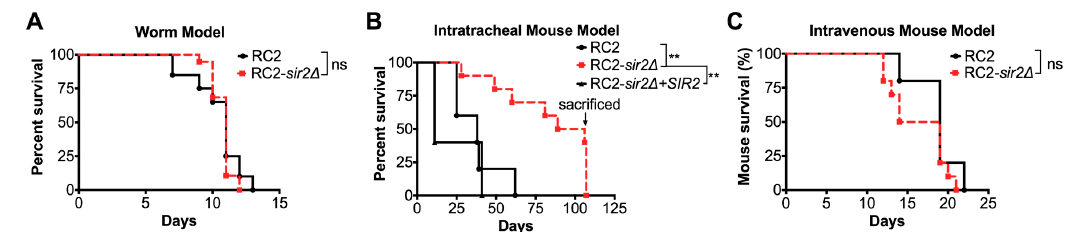
Figure 3. SIR2 loss affected virulence in some infection models. ( A ) Galleria mellonella larvae infected with 2 × 10 4 RC2- sir2 Δ cells demonstrated no significant survival difference compared to those infected with wt cells (ns by Log Rank test); ( B ) BALB/c mice infected intratracheally with 10 6 RC2- sir2 Δ cells survived significantly longer than those infected with the wt and complemented strains (97.5 versus 38 and 11 days median, p < 0.01 by Log Rank test); ( C ) BALB/c mice infected intravenously with 10 6 RC2- sir2 Δ cells demonstrated no significant survival difference compared to those infected with wt cells (median survival 16.5 versus 19 days in mutant vs. wt, ns by Log Rank test). Experiments were performed in duplicates ( n = 10 mice). p- values were calculated by Wilcoxon Rank Sum test (** p < 0.01, ns not significant).